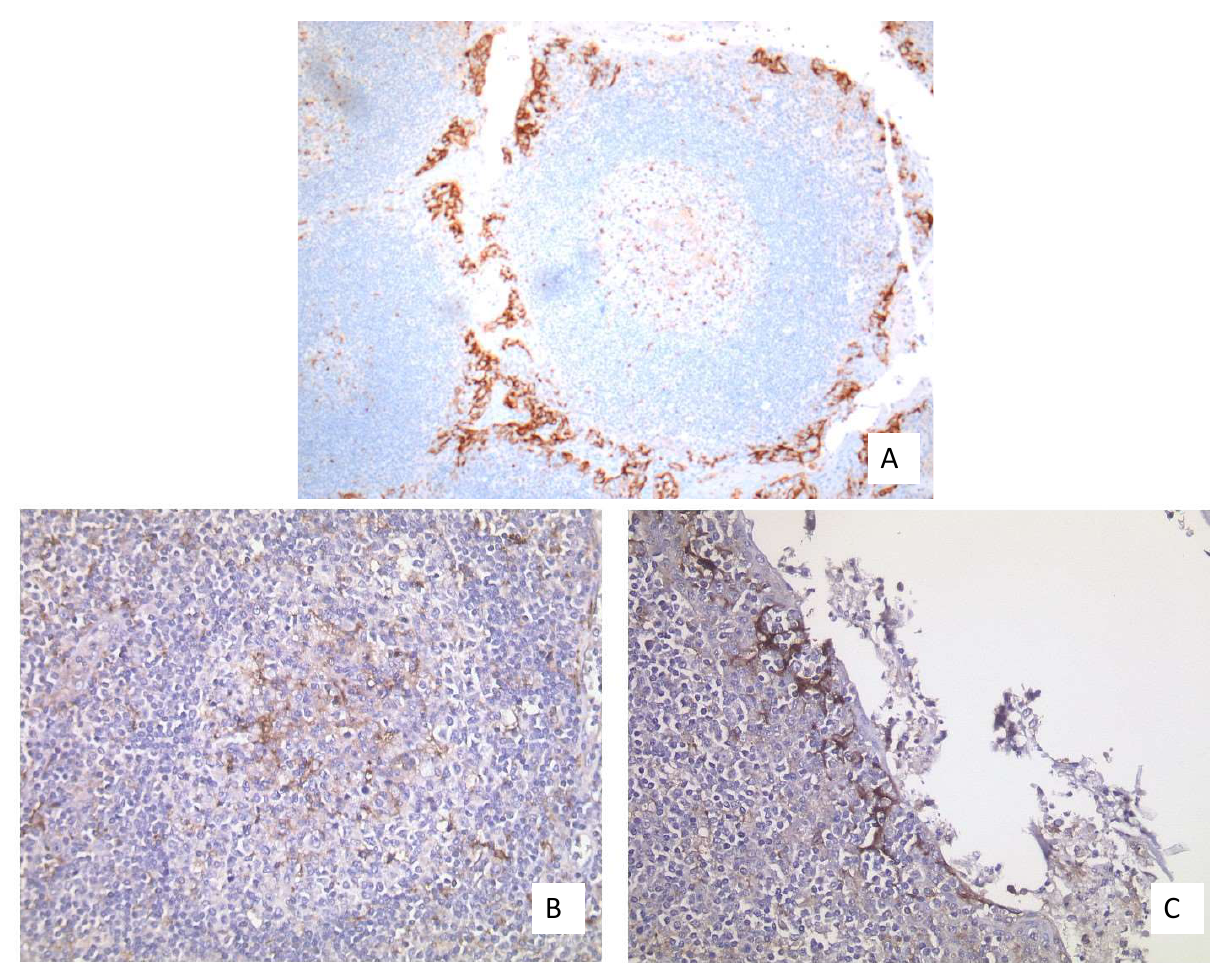
Figure 6. ( A ) Well-fixed tonsil exhibiting PD-L1 expression at two different sites (20 × Obj.); (B ) Moderate expression in the APCs of the germinal centers (40 × Obj.); ( C ) Strong expression in the epithelium of the deep crypts (40 × Obj.). Placental tissue (Figure 7A) and the tissue of classical Hodgkin lymphomas (Figure 7B) should not be used for establishing controls because these tissues do not have different staining intensities.